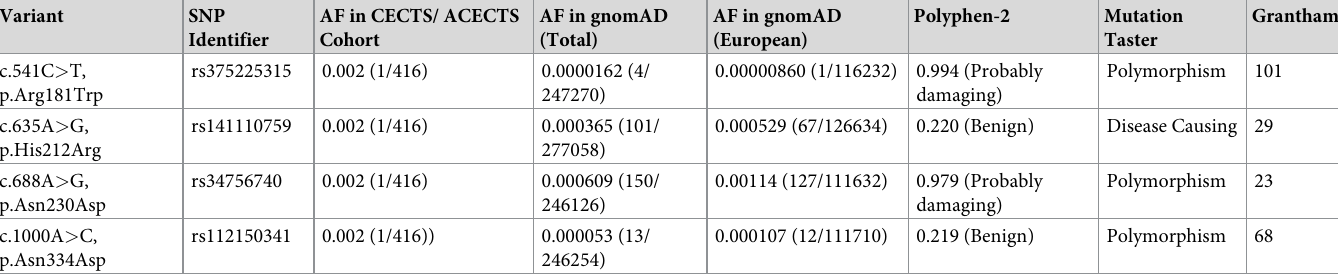
Table 2. Rare missense variants identified in replication cohort comprising 208-patient CECTS/ACECTS cohort (NM_015443.3).